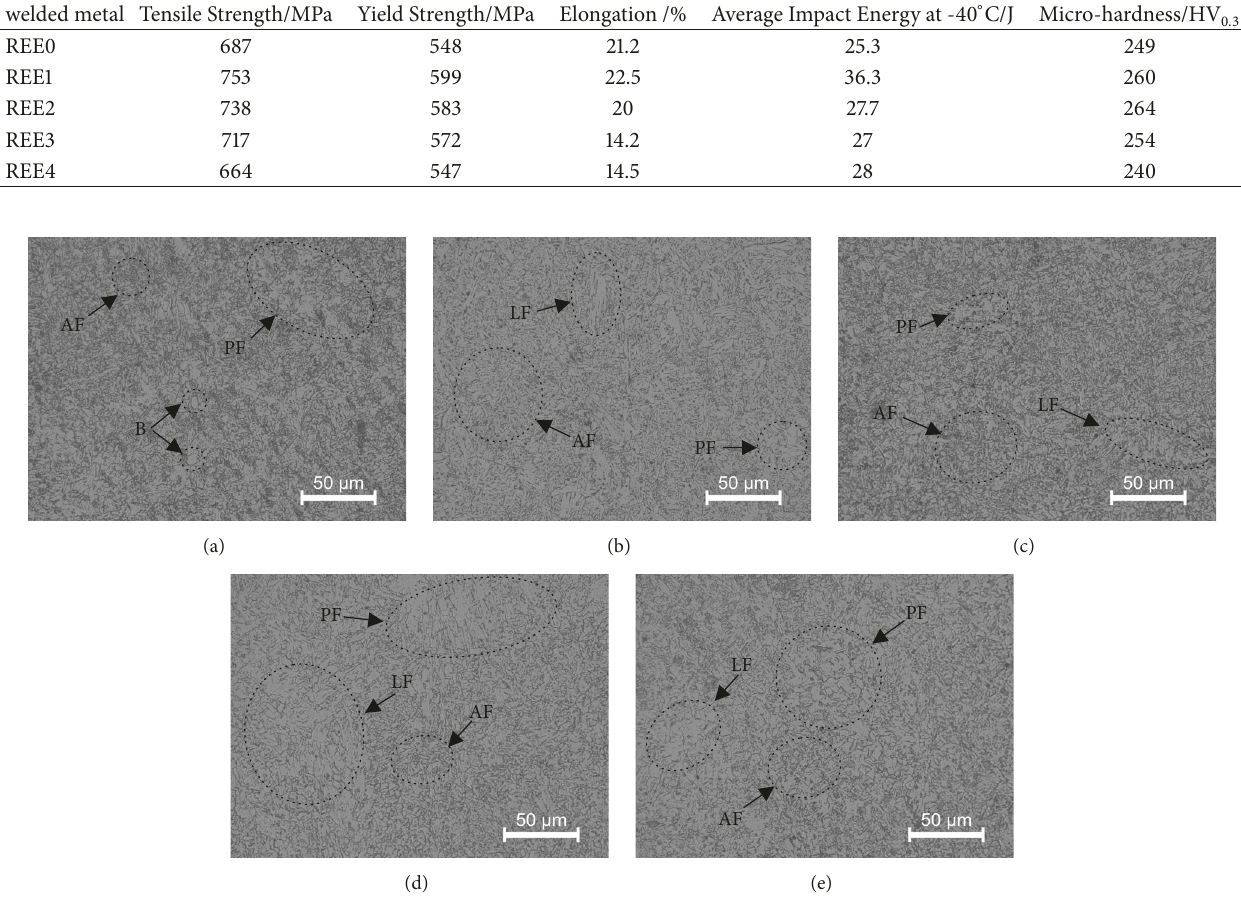
Figure 4: OM images of FCAW-welded metals for different REE contents:(a) REE-free, (b) 0.3 wt.%, (c) 0.5 wt.%, (d) 0.7 wt.%, and (e) 1.0